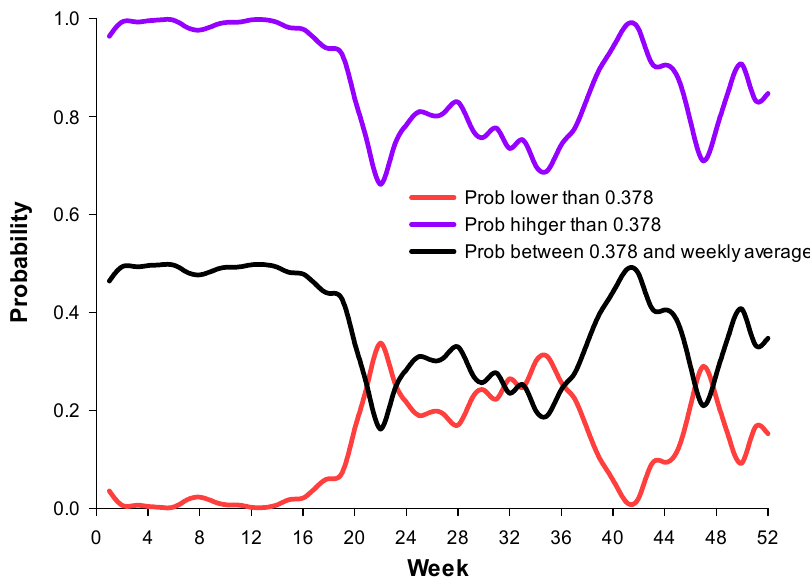
Figure 2. Probability that the price of peppers will be higher or lower than 0.378 € kg − 1 .